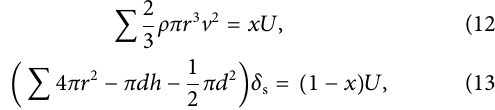
FIGURE 8 | Variation pattern of splash rate of fragments with the ratio of elastic strain